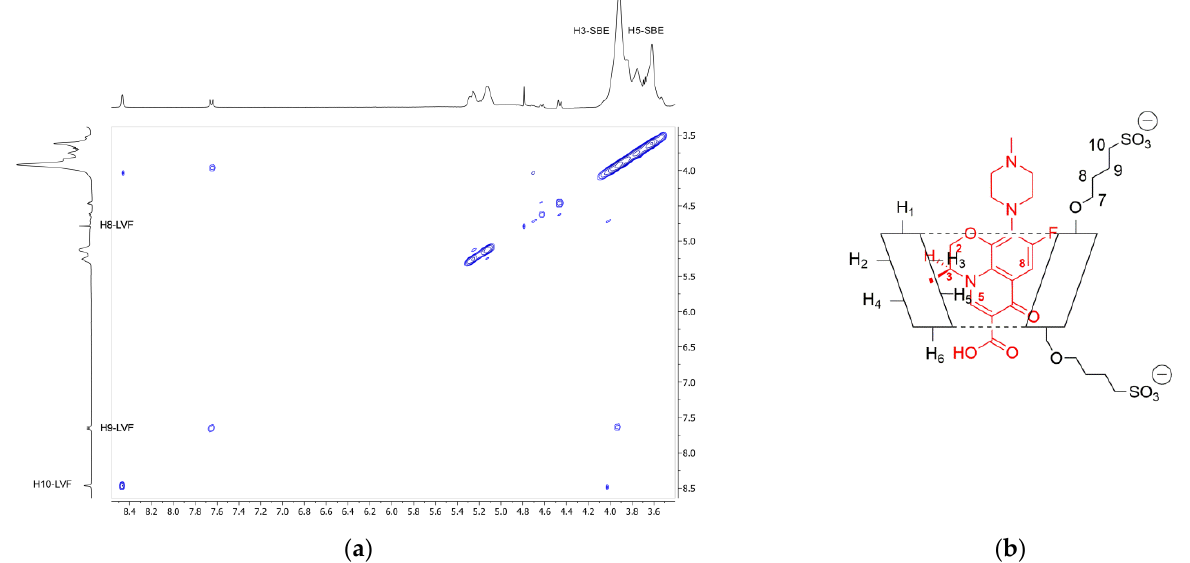
Figure 4 . ( a ) Expansion of 2D ROESY plot of LVF/SBE- β -CD inclusion complexes with cross-peaks of interest; ( b ) geometry of the inclusion complex deduced form the observed interactions.